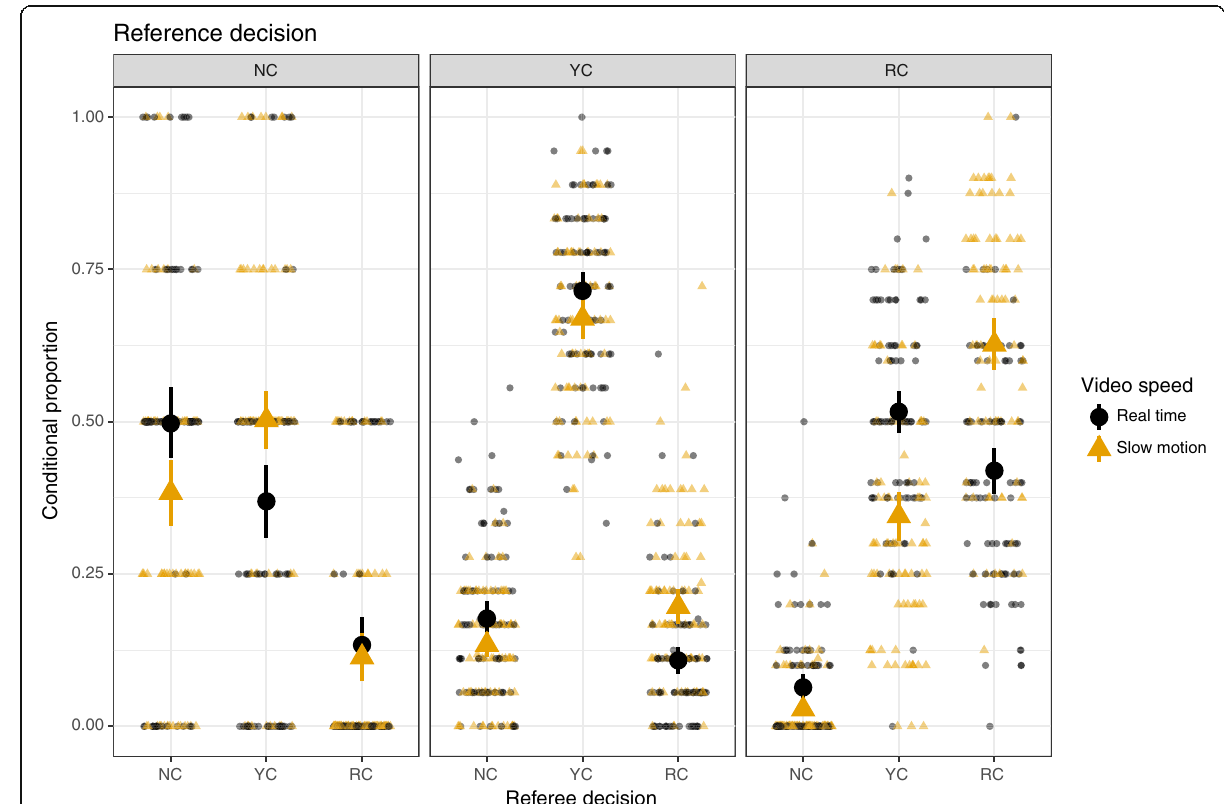
Fig. 3 Conditional proportion of responses for each combination of reference decision and video speed condition. Each set of three dots indicating the combination of reference decision and video speed thus sums to 1. The error bars represent bootstrapped 95% confidence intervals. NC no card, YC yellow card, RC red